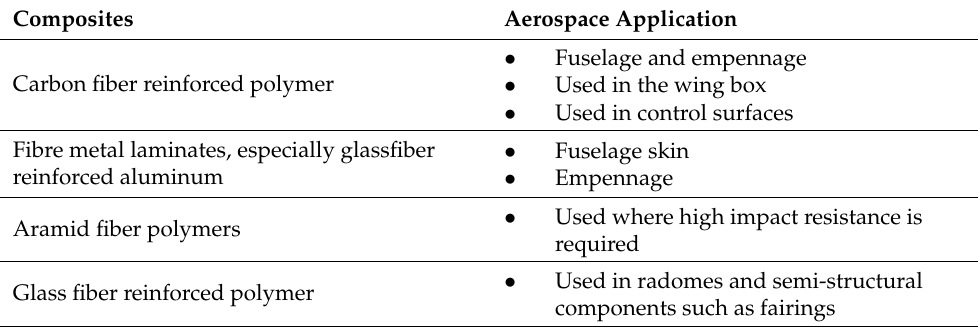
Table 2. Different composites and their